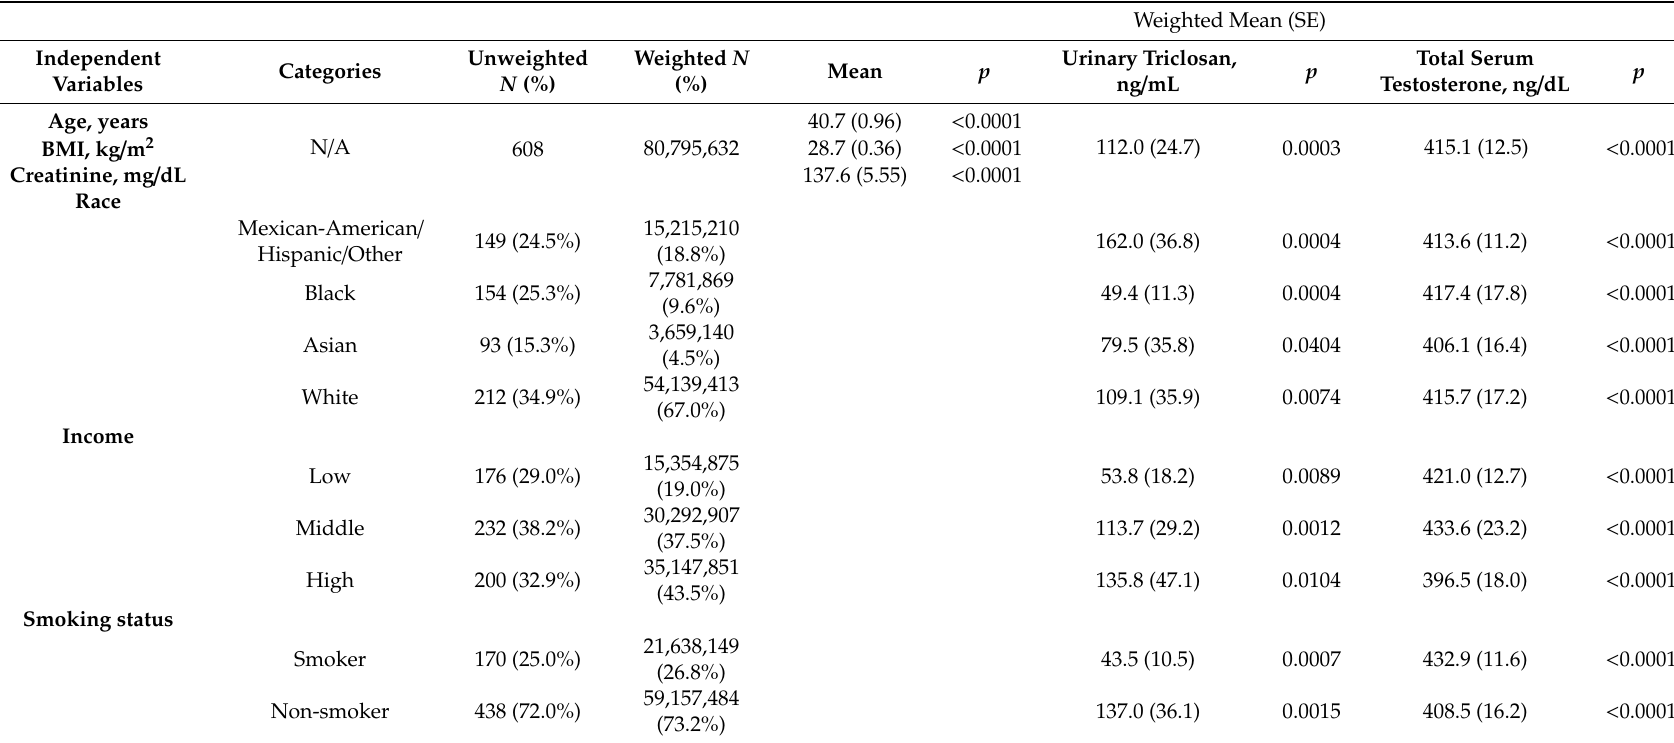
Table 2. Weighted mean levels [standard deviation (SE)] of urinary triclosan and total Serum testosterone by potential confounders.